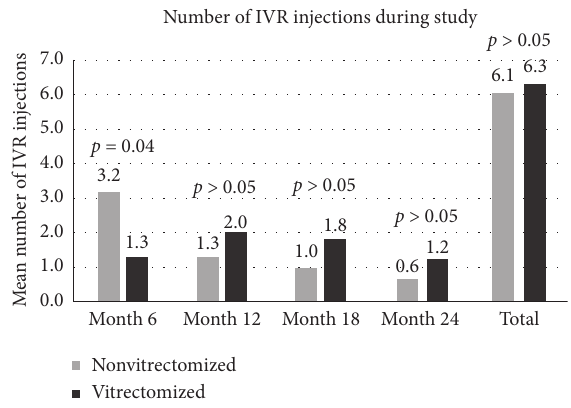
Figure 1: The mean number of intravitreal ranibizumab (IVR) injections given to the study groups during 24 months of follow-up. p values indicate the outcome of statistical testing for the com- parison between groups for the corresponding time of evaluation.